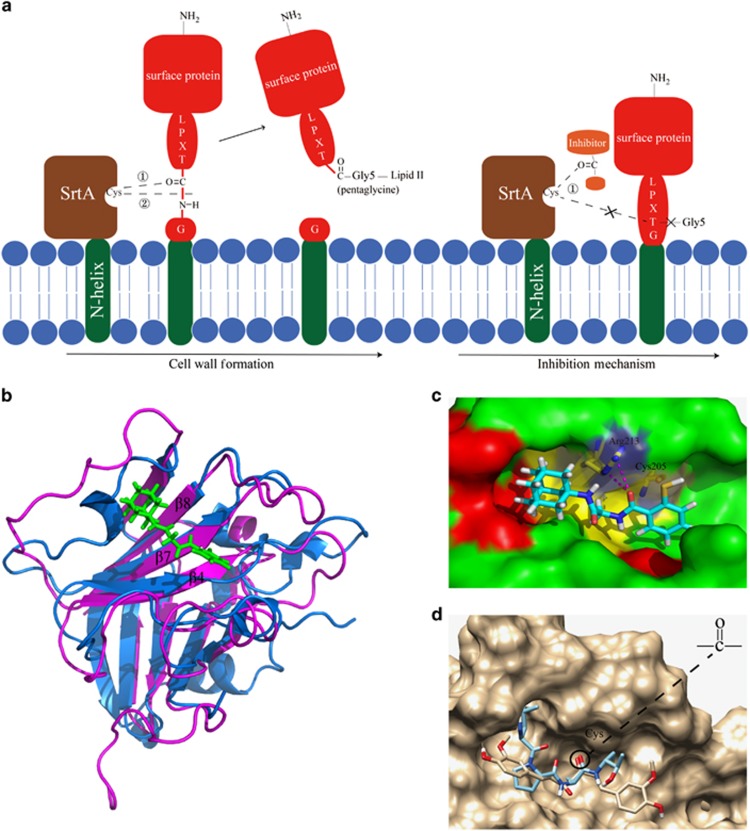
Mechanism of SrtA catalysis and inhibition of SrtA and the active site determination of S. mutans SrtA in the catalytic domain using the crystal structure of S. aureus SrtA. (a) In cell wall formation, ① Cys205 of SrtA recognizes the carbonyl of the LPXT-G motif of surface proteins. ② Cys205 attacks the peptide bond between threonine and glycine. Then, the exposed carboxyl of threonine is amide-linked to the pentaglycine cross-bridge to benefit biofilm formation. Regarding the inhibition mechanism, the carbonyl of inhibitors can replace that of surface proteins to inhibit catalysis. ① Cys205 recognizes the carbonyl of the inhibitor, then hydrogen bonds or Michael addition are formed between them to impede SrtA catalysis. (b) SrtA crystal structures of S. mutans (blue) and S. aureus (magentas) with its inhibitor (green). (c) The surface of S. mutans SrtA with the inhibitor of S. aureus SrtA in the active site after docking. Helix, sheet and loop surfaces are indicated in red, yellow and green, respectively. The colours of carbon, hydrogen, oxygen, nitrogen and sulfur atoms of the inhibitor are cyan, white, red, blue and orange, respectively. The colour of hydrogen bonds is magenta. (d) Curcumin (white) occupies the catalytic centre, and the LPXTG motif (cyan) does not enter the binding pocket. SrtA, sortase A.